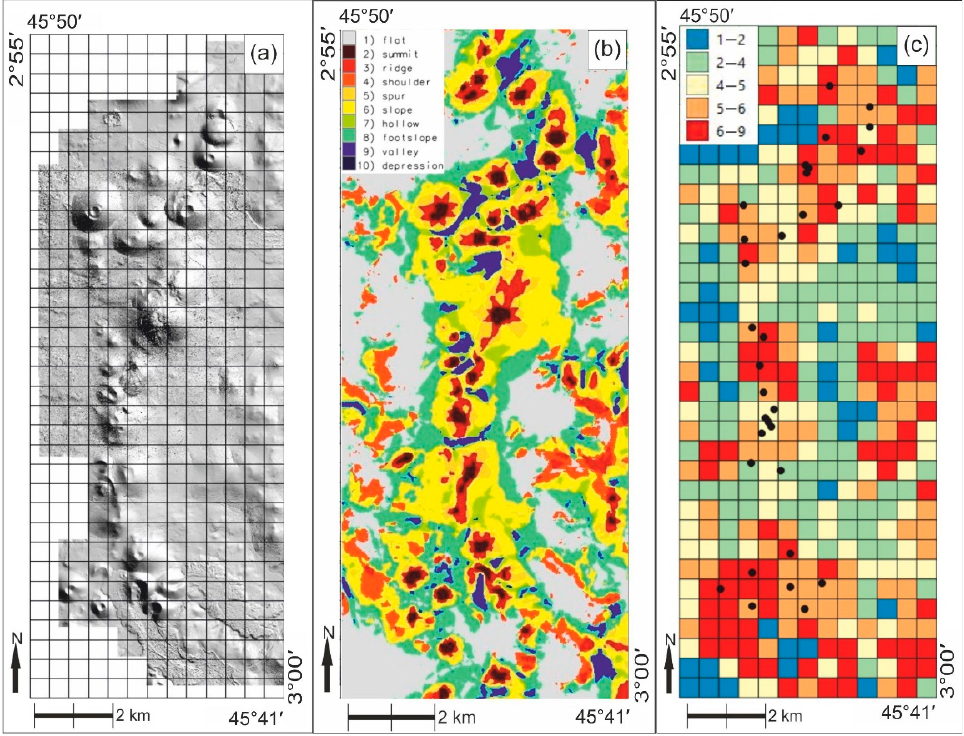
Figure 6. ( a ) Shaded relief map for orientation. ( b ) Geomorphons. ( c ) Geomorphological subindex produced from these data. Black dots indicate the scoria cone centers.